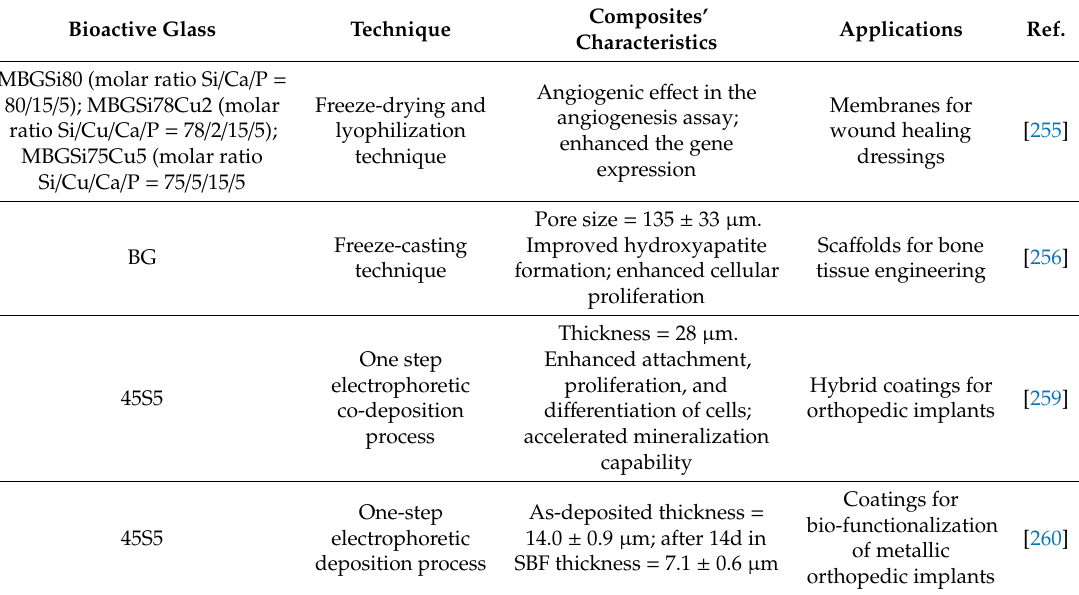
Table 7. Summary of cellulose / bioactive glass composites for biomedical